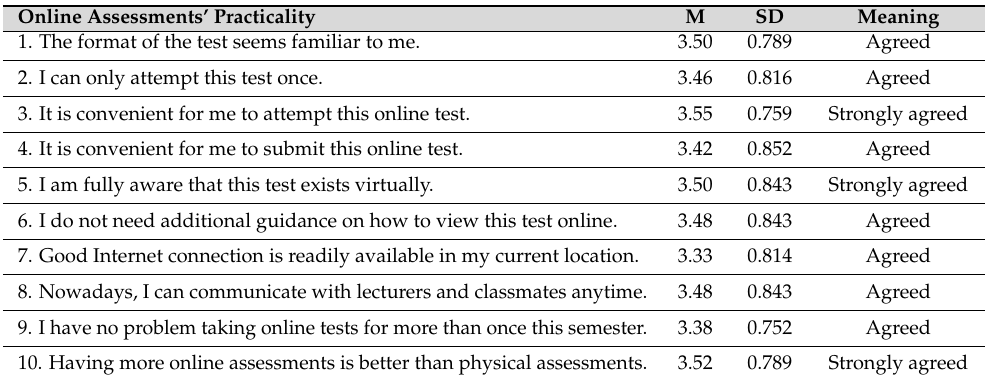
Table 2. Mean and standard deviation for second section.